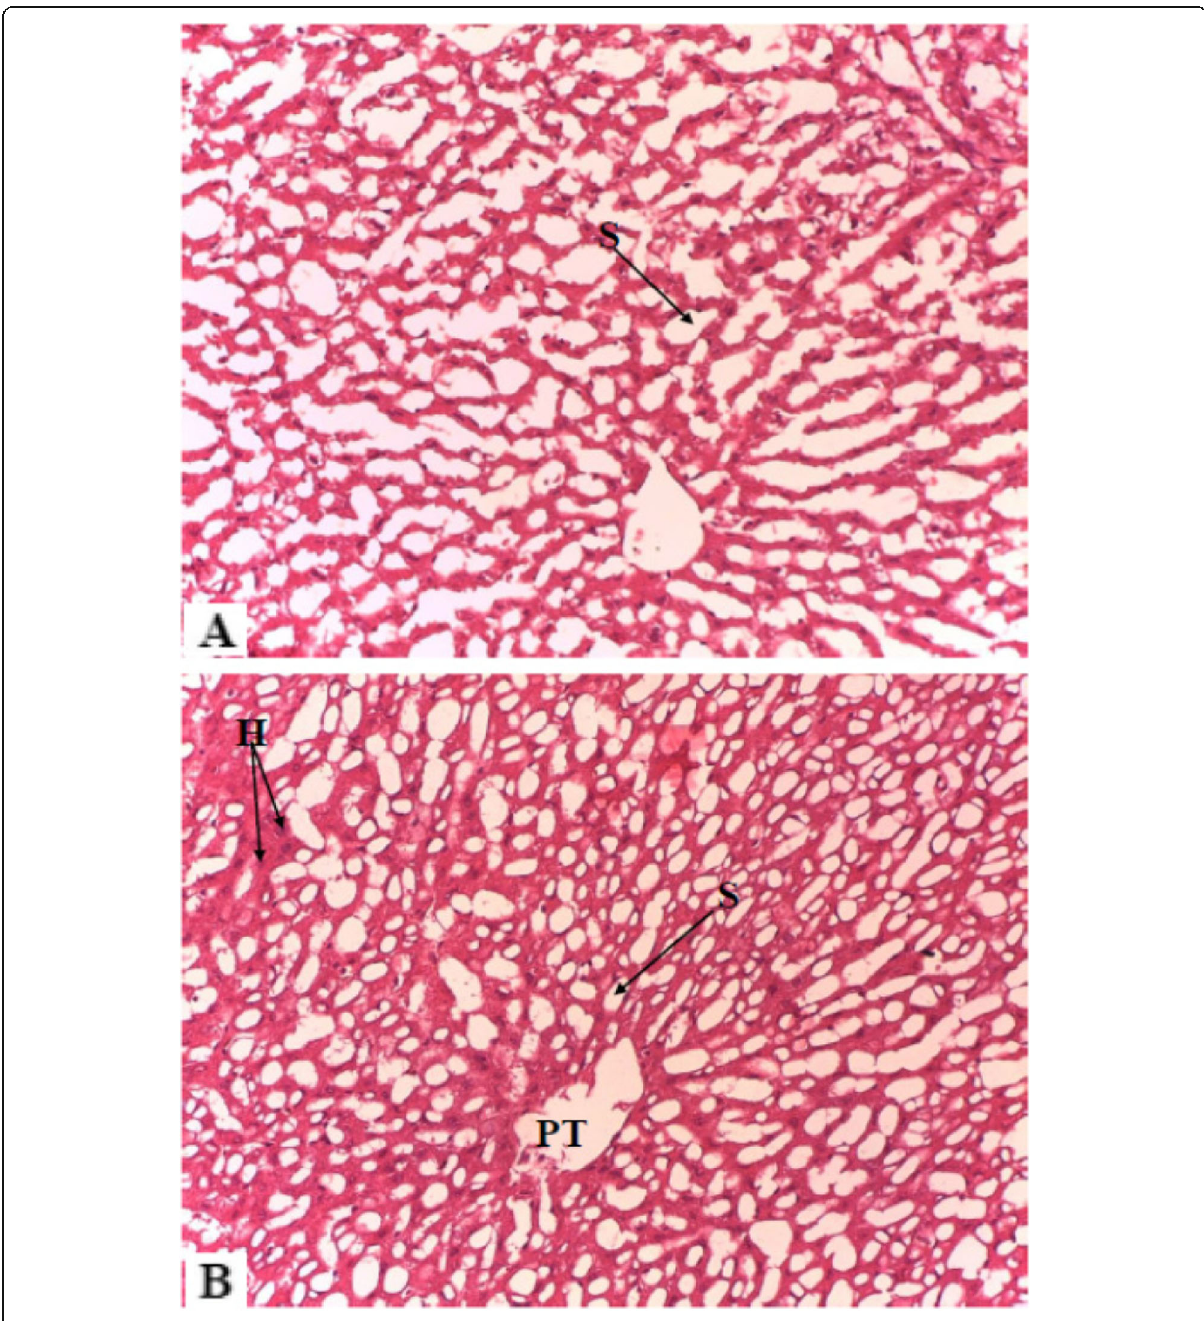
Fig. 4 Photomicrographs of liver sections of normal rat showing normal hepatocyte (H), portal tract (PT) and sinusoids